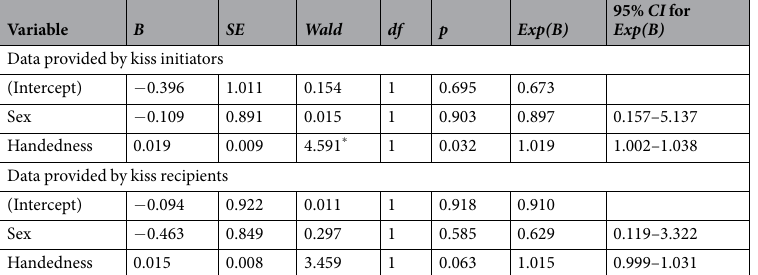
Table 3. Effects of sex and handedness on the kiss initiators’ head-turning direction demonstrated through binary logistic regressions. Note. N = 48. Coding independent variable, Sex: Male = 1.000; Female = 0.000 (Reference category). Coding dependent variable, Kiss initiator’s head-turning direction: Left = 0; Right = 1.